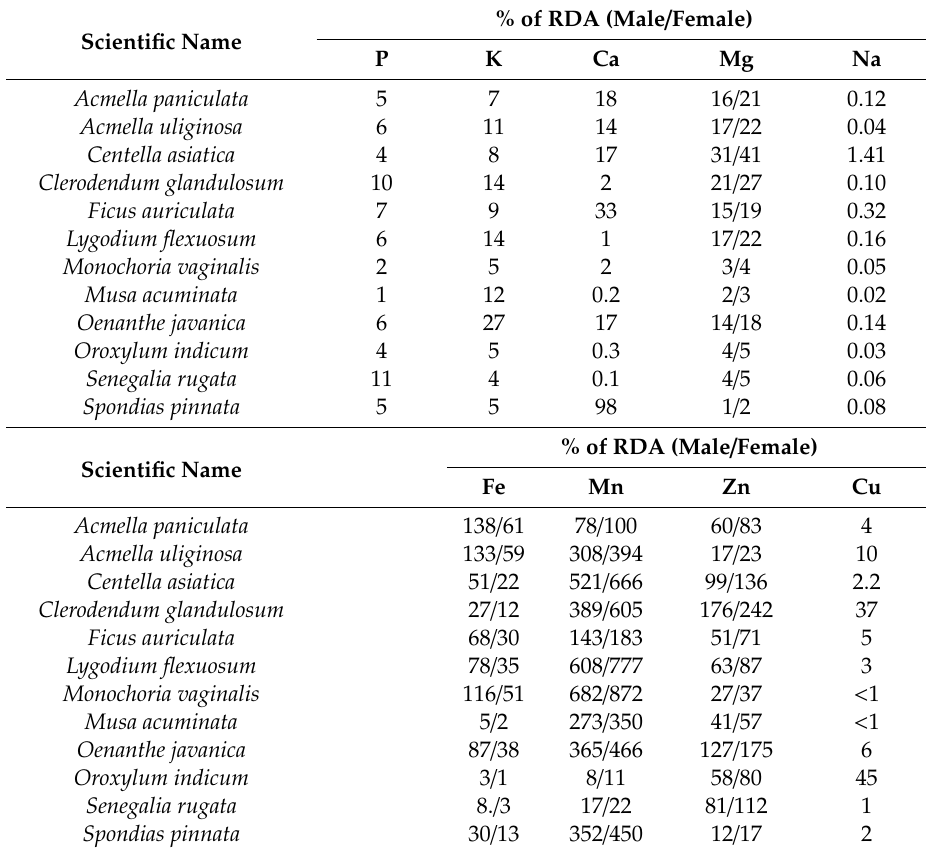
Table 4. Percentages of contribution to the recommended dietary allowance (RDA) (mg / day) [59], for adults, of macrominerals (P, K, Ca, Mg, and Na) and trace minerals (Fe, Mn, Zn, and